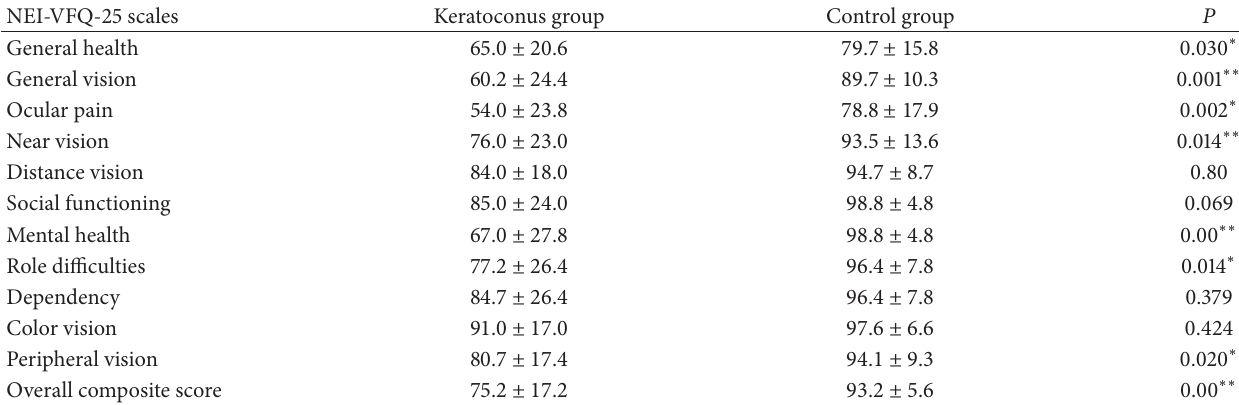
Table 2: NEI-VFQ-25 subscale scores according to the groups ( ∗ 𝑃 < 0.05 ; ∗∗ 𝑃 < 0.001 ). NEI-VFQ-25